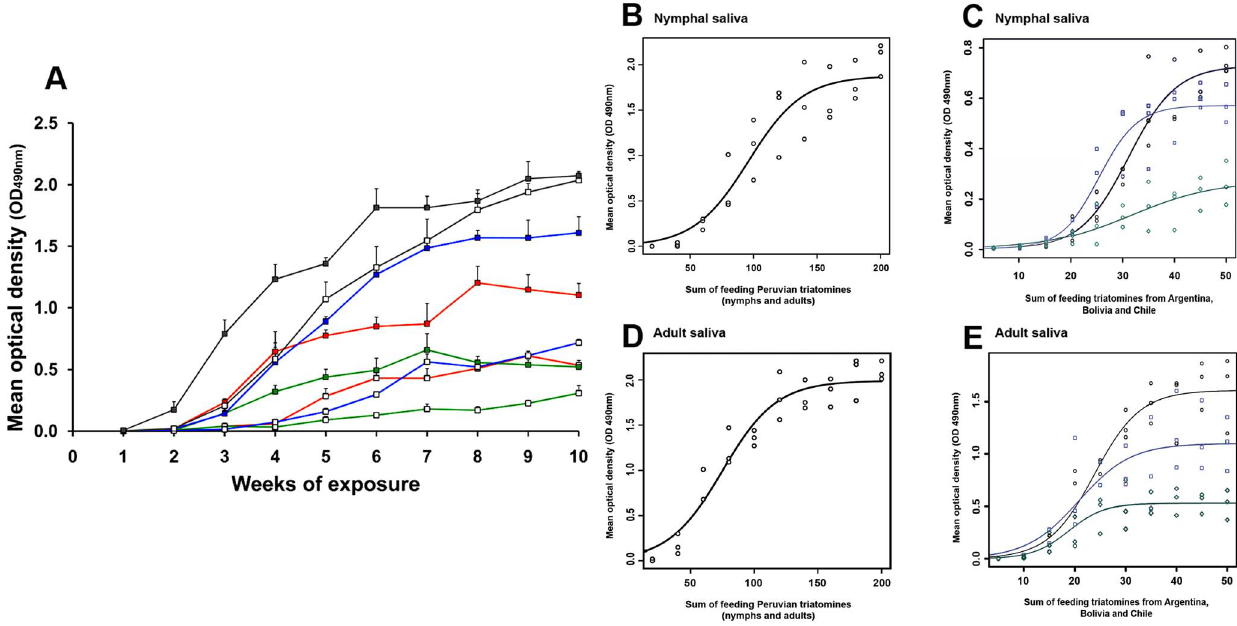
Figure 3. IgG antibody response of guinea pigs to saliva of nymphal and adult T.infestans of four different strains. (A) Eighteen guinea pigs were either exposed to the 5 th instar (n=5, white squares) or adults (n=5, colored squares) of three different T. infestans strains from Argentina (blue line), Bolivia (red line) and Chile (green line). Each group of animals was made of 3 guinea pigs. Additionally, three guinea pigs were exposed to a set of nymphs (n=10, white squares) and adult triatomines (n=10, grey squares) from Peru (grey lines). Guinea pigs were exposed weekly to triatomines and for a period of 10 weeks. Animals were bled 5 days after each exposure and all sera were analyzed by ELISA using either crude saliva of nymphs or adults. From each group of guinea pig sera (n=3) the mean optical density (O.D. 490 nm ) was calculated after subtracting the O.D. of the negative control (pre-exposure). The results here presented show the final mean optical densities (O.D. 490 nm ) of two independent ELISA assays. (B–E) Logistic models describing the relationship between the sum of feeding nymphal and/or adult triatomines (number of triatomines used at each feeding event plus the number of triatomines already fed in previous events) and the corresponding IgG antibody level of guinea pigs to saliva of the Peruvian (B, D), Argentinean (C, E, black graphs), Bolivian (C, E, blue graphs) and Chilean T. infestans strains (C, E, green graphs).